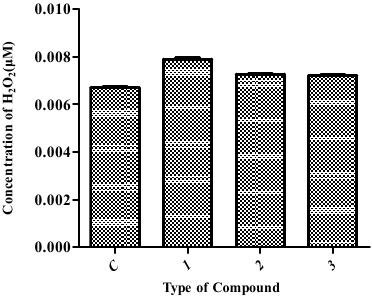
Figure 5. H 2 O 2 concentrations of EGCG and EGCG glycosides: EGCG ( 1 ), EGCG-G1 ( 2 ) and EGCG-G2 ( 3 ), tested using a H 2 O 2 Quantitative Assay Kit (Water-Compatible).